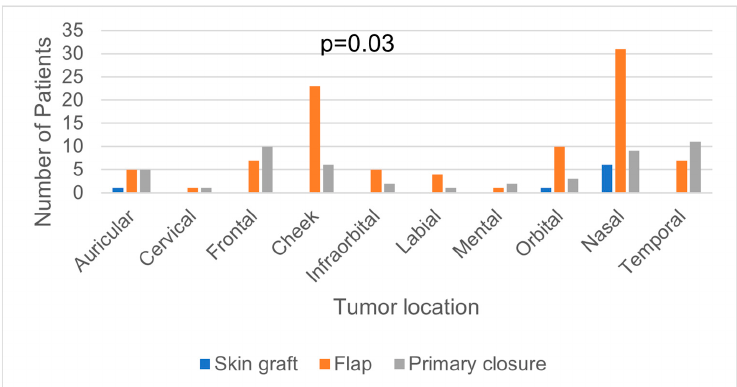
Figure 4. Correlation between tumor stage and days of hospitalization.